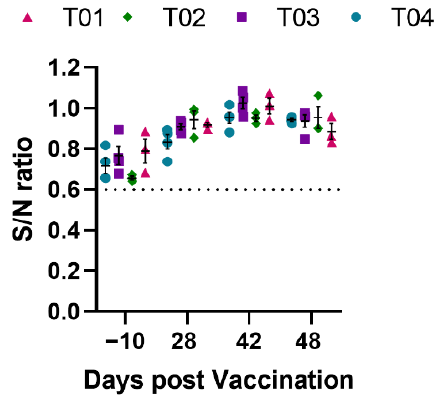
Figure 6. Antibodies against IAV-S NP protein measured by a blocking ELISA. Data are expressed as the sample to negative (S/N) ratio. The horizontal dotted line at S/N of 0.6 is the assay cutoff. Test samples with S/N greater than 0.6 are considered to be negative. T01 — PBS; T02 — rPICV-GFP; T03 — rPICV-H3; T04 — H3-protein.